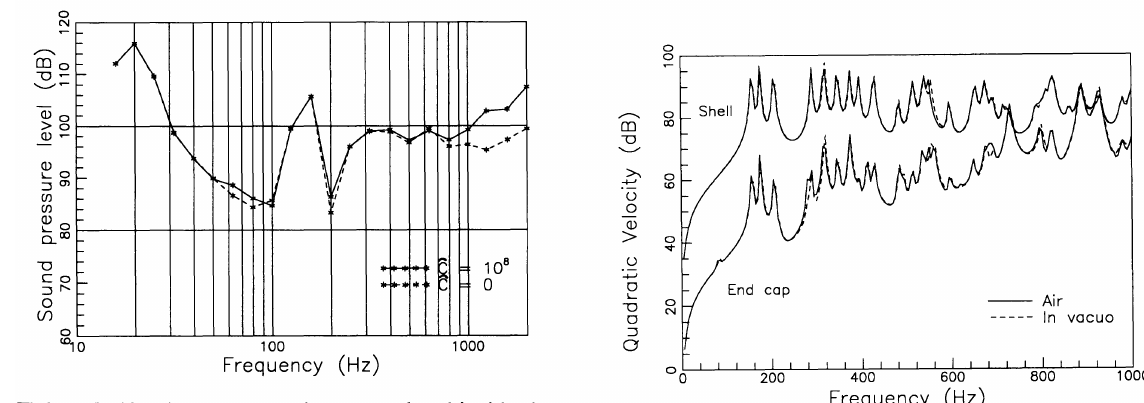
FIGURE 10 A verage sound pressure level inside the cavity in one-third octave bands with two limiting shell-plate joint conditions in rotation.